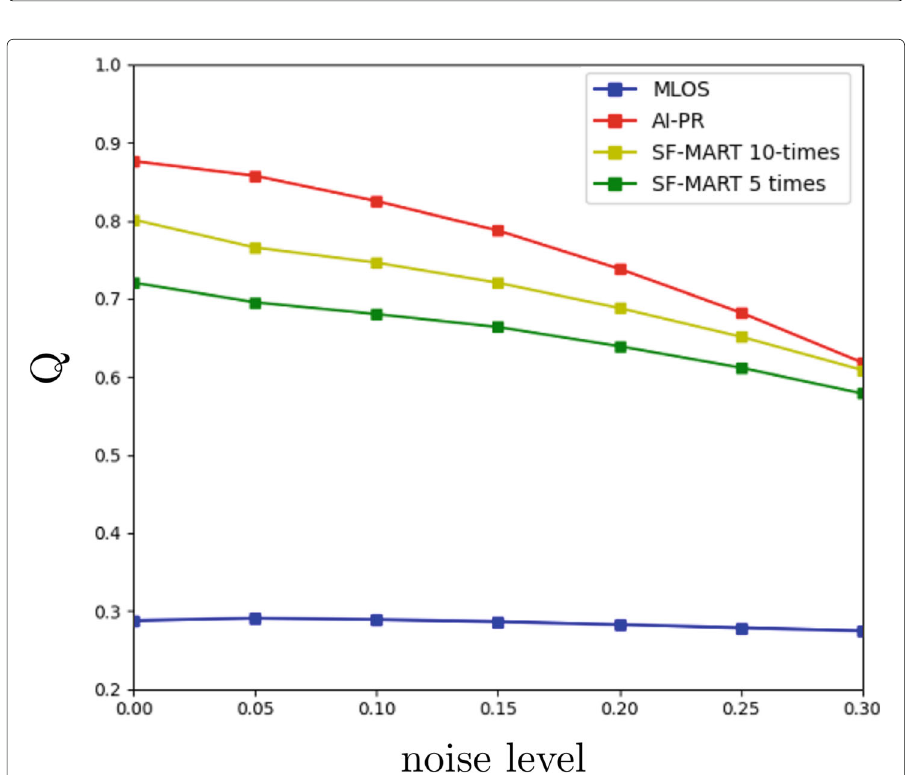
Fig. 6 Quality factor Q of different methods with varying noise levels from 0 to 0.3 with an interval of 0.05 at